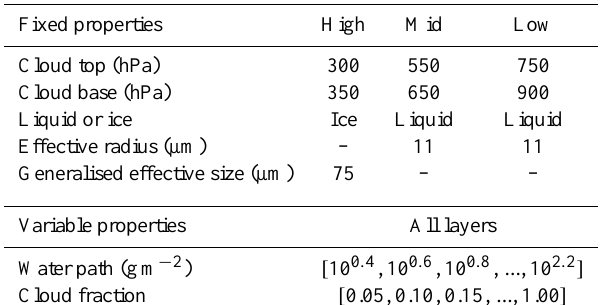
Table 2. Parameter values used in the large cloud tuning ensemble. Optical depth depends logarithmically on water path. Water path and cloud fraction are varied independently for each layer. Water paths range from optically thin to optically thick clouds (Curry and Webster, 1999) with 10 values. Cloud fractions range from 5% to 100% coverage with 20 cases. Effective radius is for water clouds (low and mid level) and generalised effective size is for ice clouds (high). There there are 10 3 × 20 3 =8 × 10 6 cases in total.